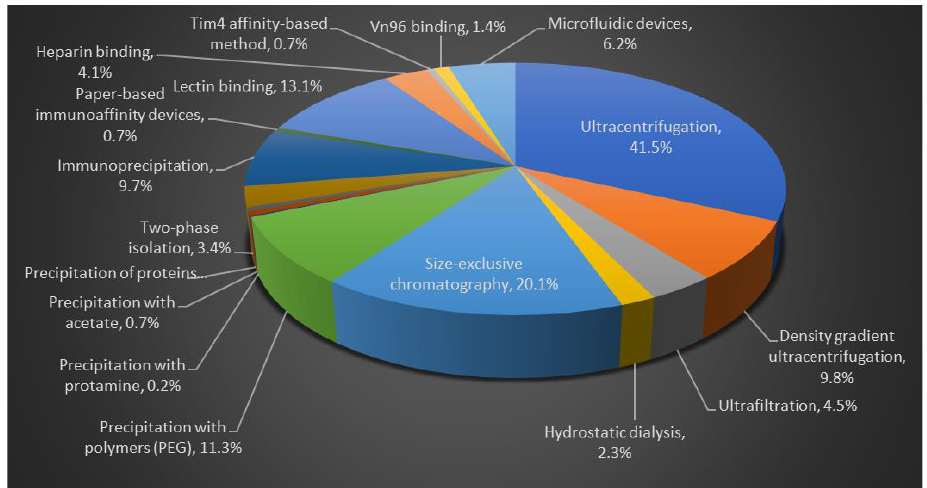
Figure 2. Comparison of different isolation methods for EVs purification. Flow chart data is based on published literature.